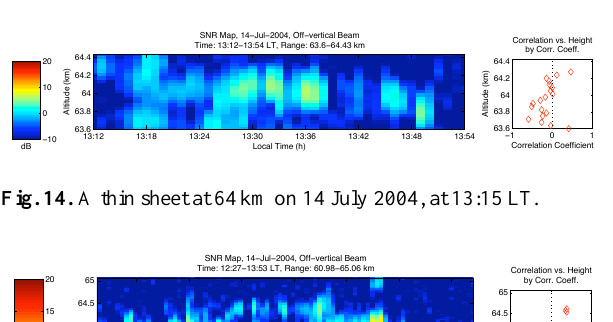
Fig. 15. Thin sheets at 60 km on July 14 at 12:27 LT.